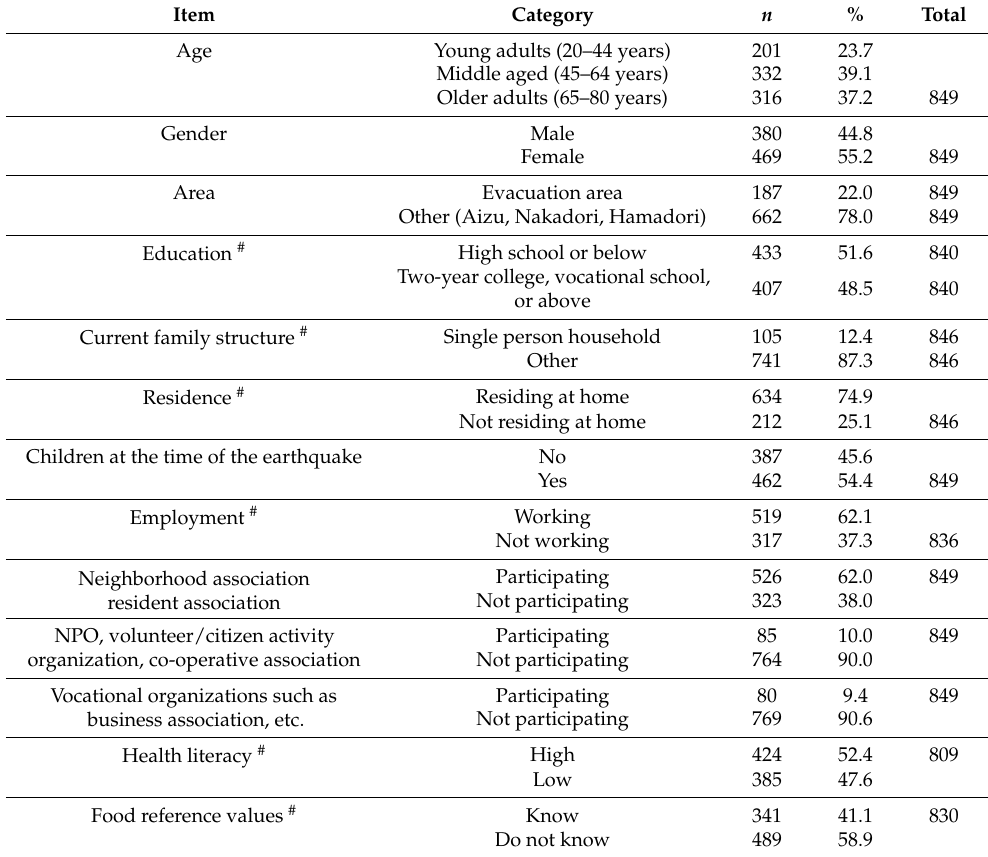
Table 1. Basic information of the respondents.